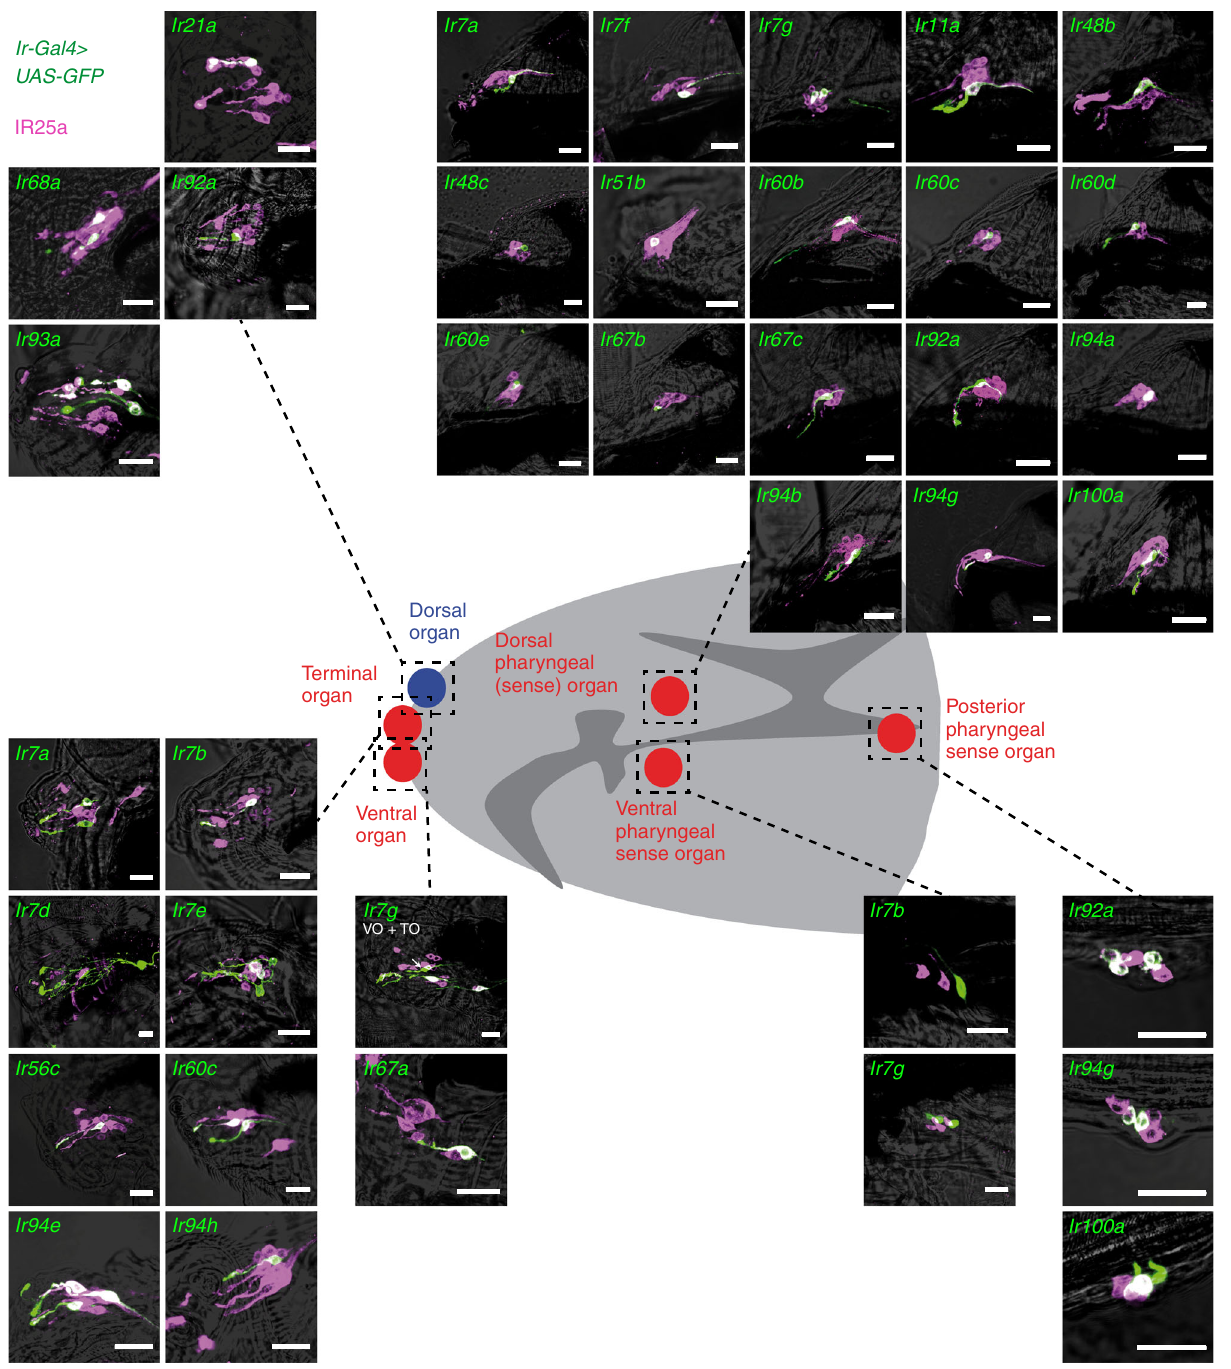
Fig. 2 Expression of Ir-Gal4 drivers in the peripheral nervous system of larval Drosophila . Immuno fl uorescence with anti-GFP (green) and anti-IR25a (magenta), overlaid on bright- fi eld images, on whole-mount tissue of third instar larvae, revealing the expression of Ir-Gal4 lines in different chemosensory organs (as schematised in the cartoon of the larval head in the centre). Ir7g-Gal4 is expressed in both terminal organ (TO) and ventral organ (VO) neurons; the VO neuron is indicated with an arrow. Images for Ir7b , Ir7e , Ir7g , Ir56c , Ir60c and Ir94e drivers are adapted from 28 . Genotypes are of the form: w;UAS- mCD8:GFP;IrX-Gal4 . Scale bars: 20 μ (Supplementary Fig. 3b), indicating that the original promoter reporter faithfully recapitulates endogenous gene expression. To characterise the identity of the IR56d neurons, we combined the Ir56d-Gal4 driver (or an equivalent Ir56d-LexA transgene; see Methods) with reporters for other populations of labellar neurons. We fi rst con fi rmed that IR56d neurons express IR25a and IR76b (Fig. 4c), suggesting that IR56d may function